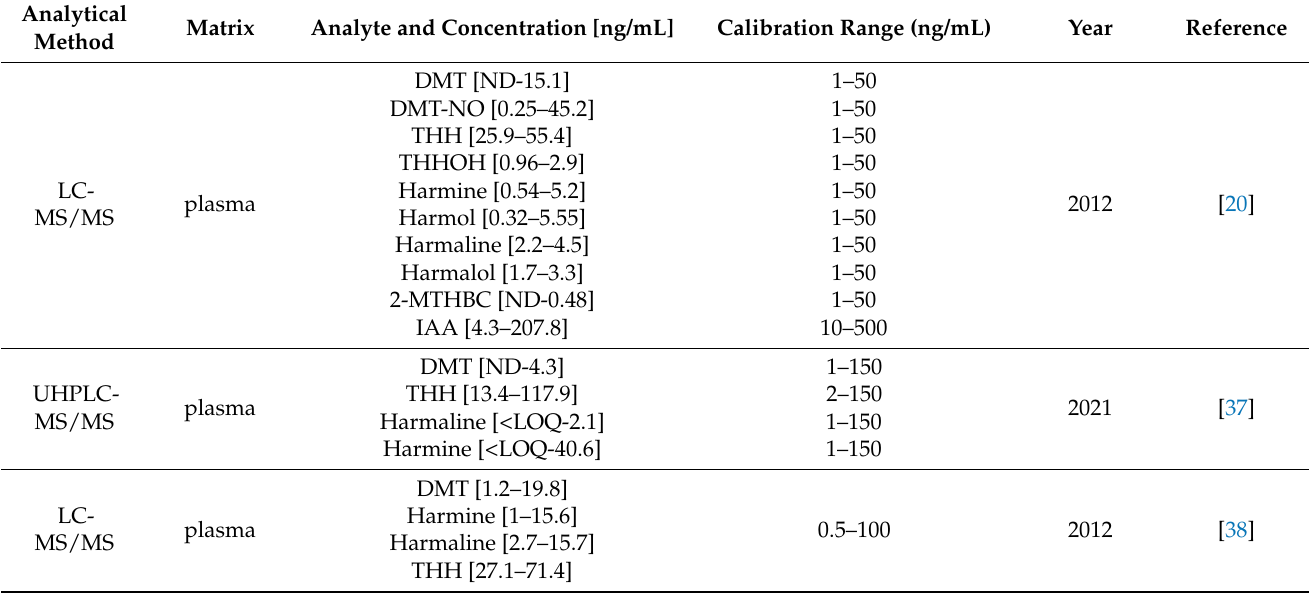
Table 3. Summary of publications covering consumption of ayahuasca decoction and concentration of individual substances derived from the decoction and their metabolites in human biological